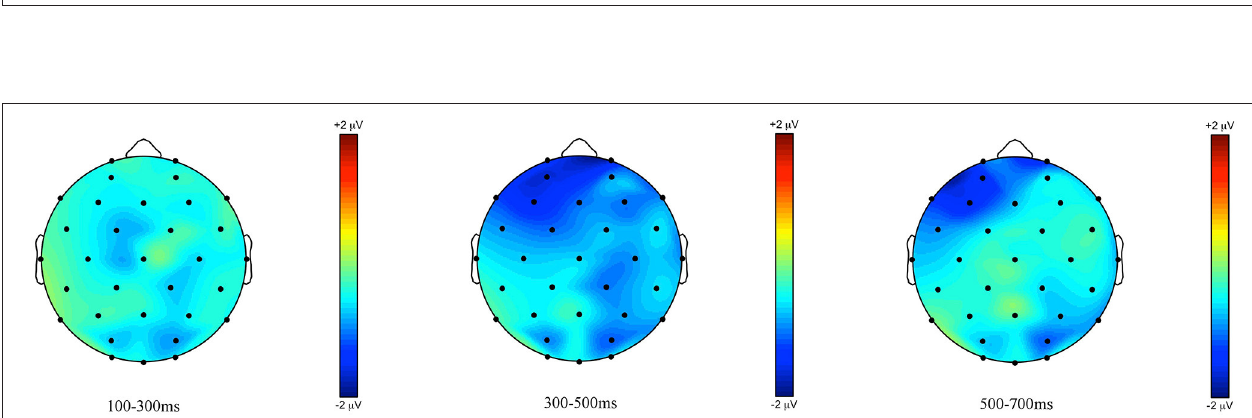
FIGURE 8 | Topographic maps of the ERPs recorded in adults, time-locked to the presentation of the word “Ein paar” ( some ) for the some -infelicitous condition minus the some -felicitous condition in the three time windows.